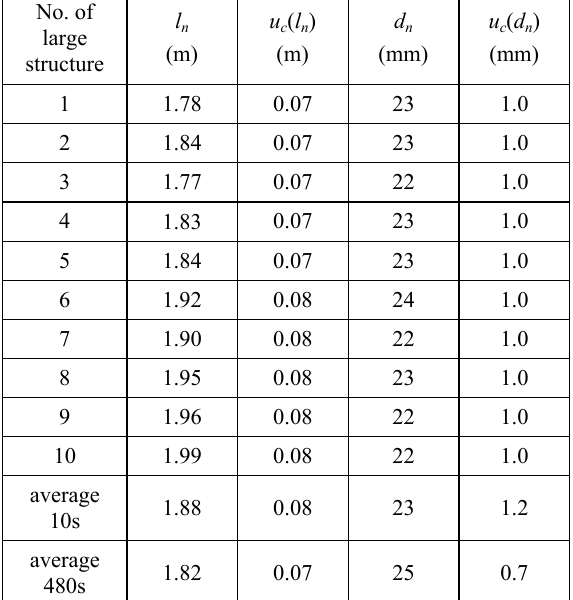
Table 1. The values of instantaneous and average length l n and depth d n of large